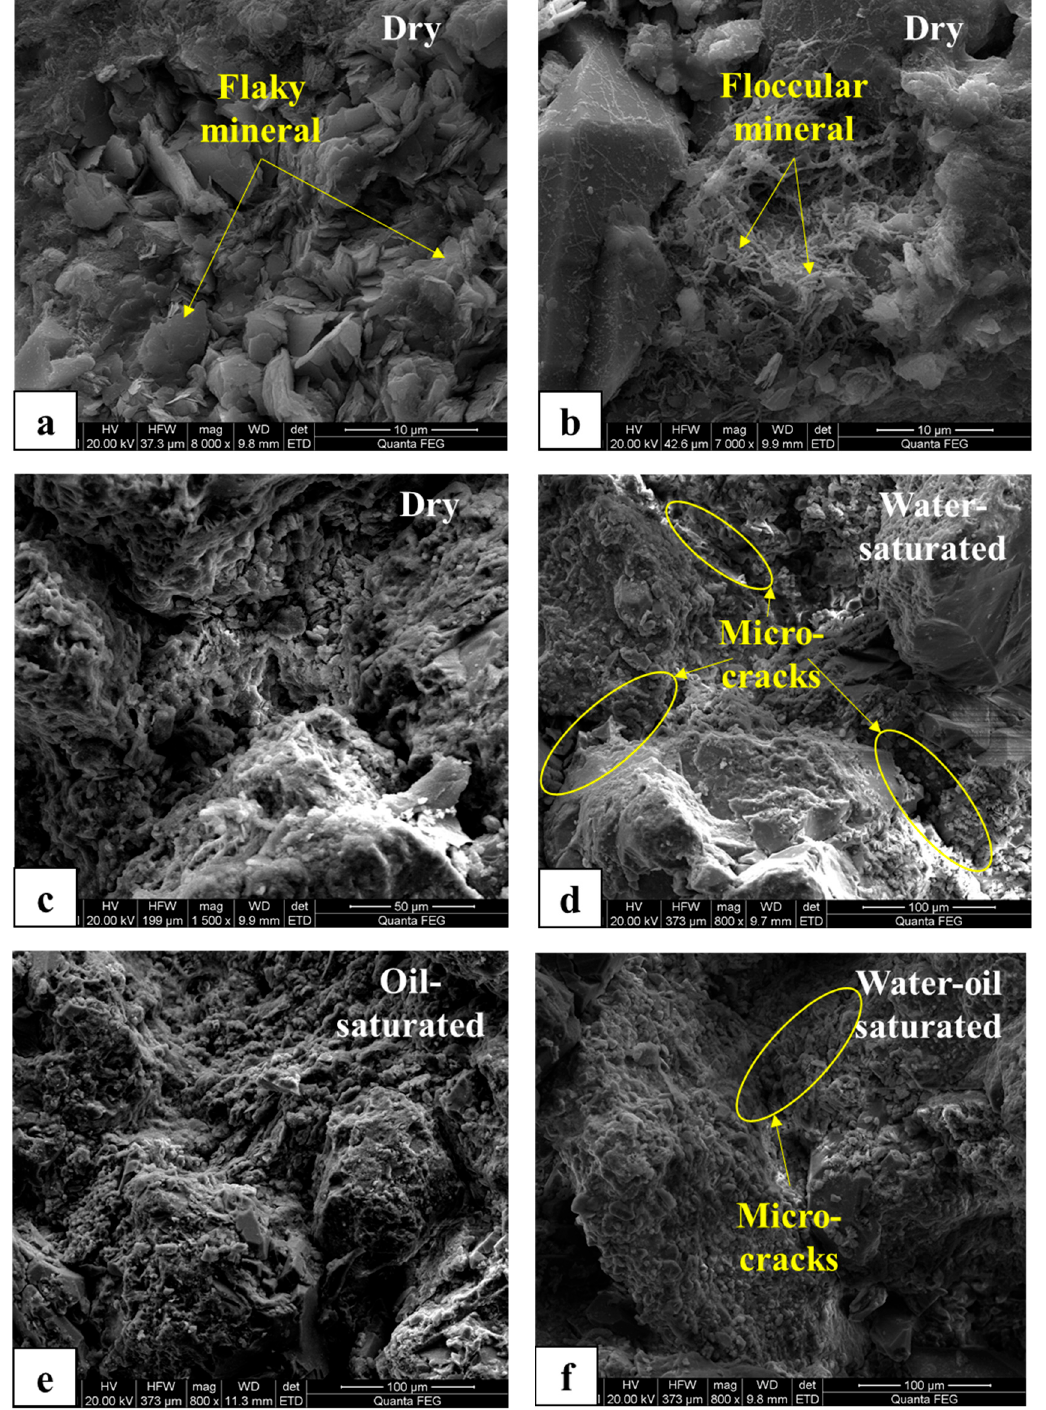
Figure 9. Scanning electron microscope (SEM) images of different saturated samples: ( a – c ) Dry sample; ( d ) Water-saturated sample; ( e ) Oil-saturated sample; ( f ) Water–oil-saturated sample.